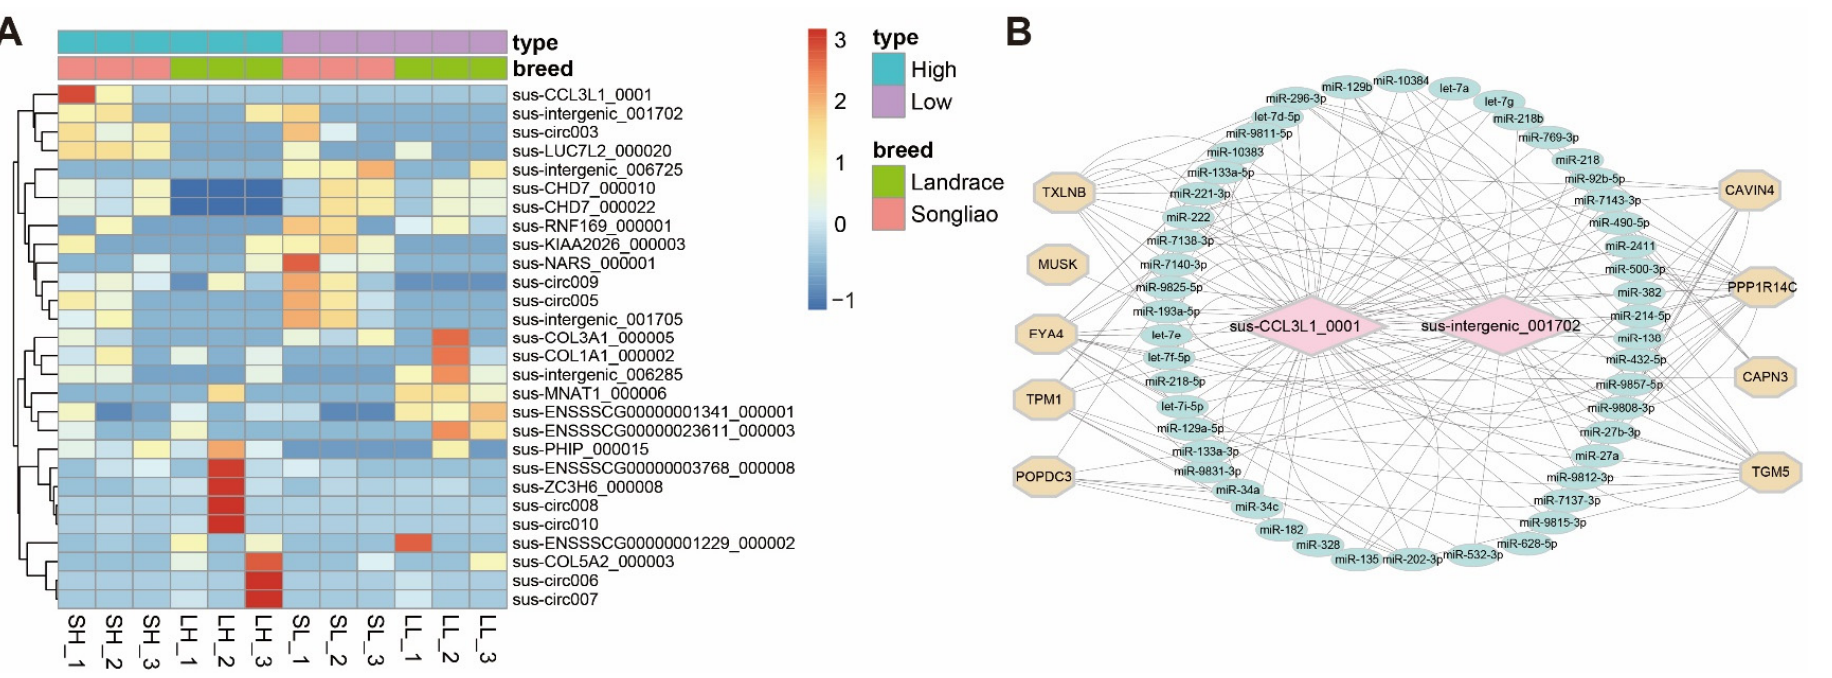
Figure 5. The results of the functional analysis of the identified DECs. ( A ) The heatmap of DE circRNAs in the four groups. ( B ) The circRNA–miRNA–mRNA interaction network.